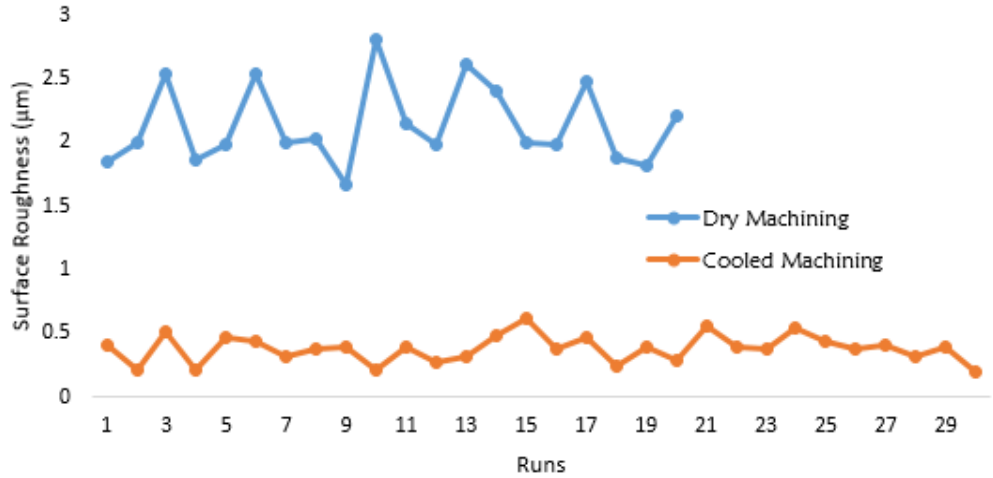
Figure 5: Surface roughness during dry and cooled machining conditions.